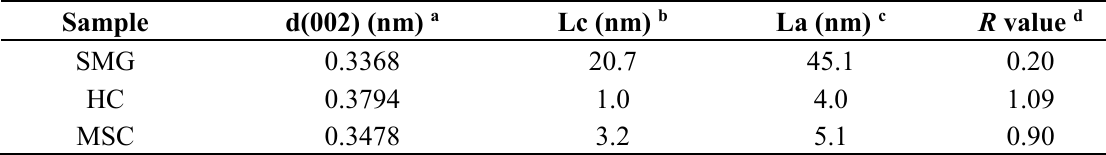
Table 2. Structural parameters of the SMG, HC and MSC anode materials estimated from XRD patterns and Raman